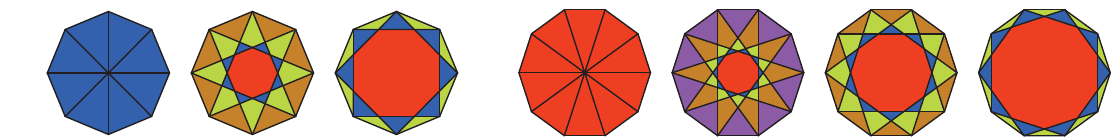
Figure 32. Rational Gielis Curves with m = 8/2, 8/3 and m = 10/2, 10/3, 10/4, 10/1.